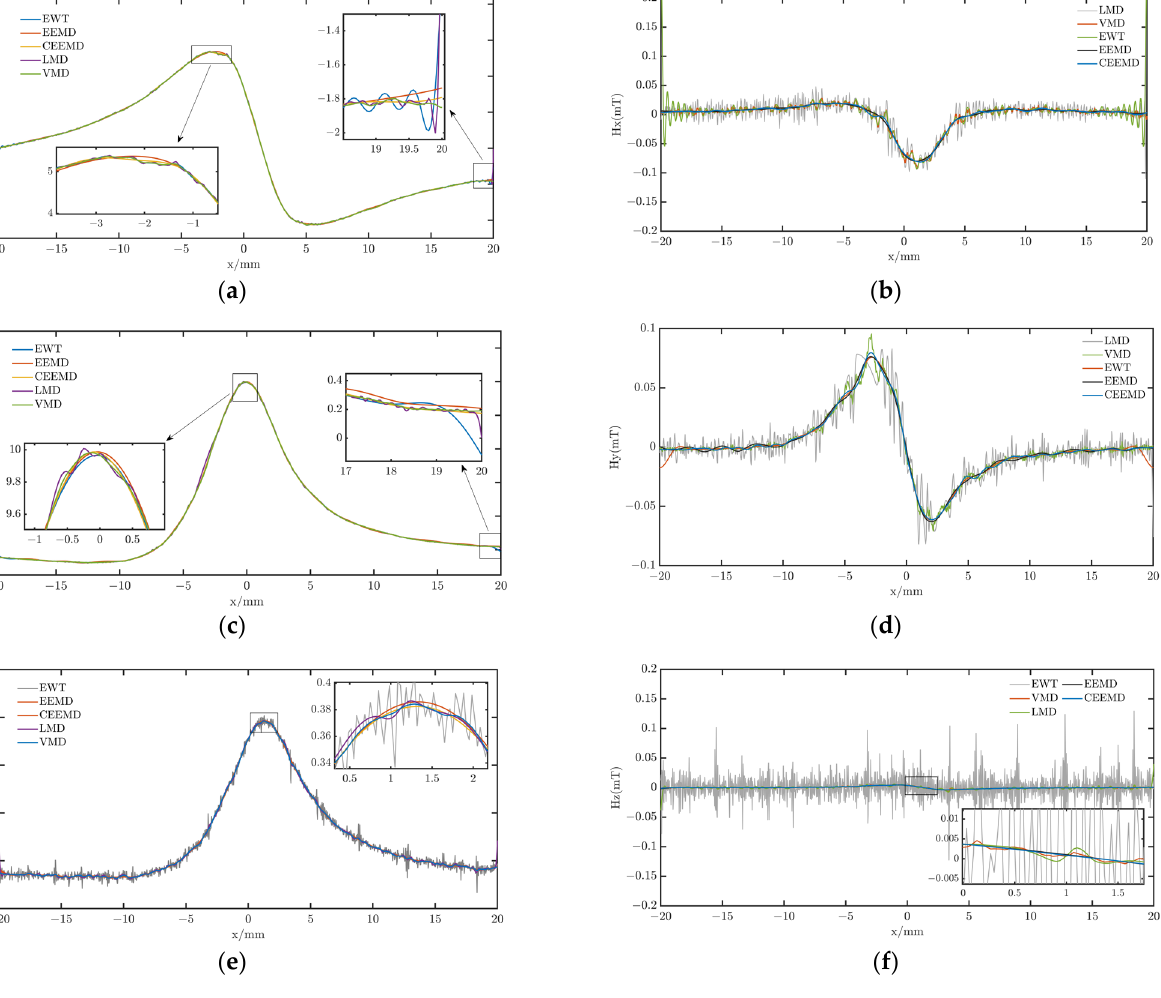
Figure 10. Comparison of signal processing methods. ( a ) Comparison of normal component signals. ( b ) Comparison of gradient values of normal component signal. ( c ) Comparison of tangential component signals. ( d ) Comparison of gradient values of tangential component signal. ( e ) Comparison of horizontal component signals. ( f ) Comparison of gradient values of horizontal component signal.